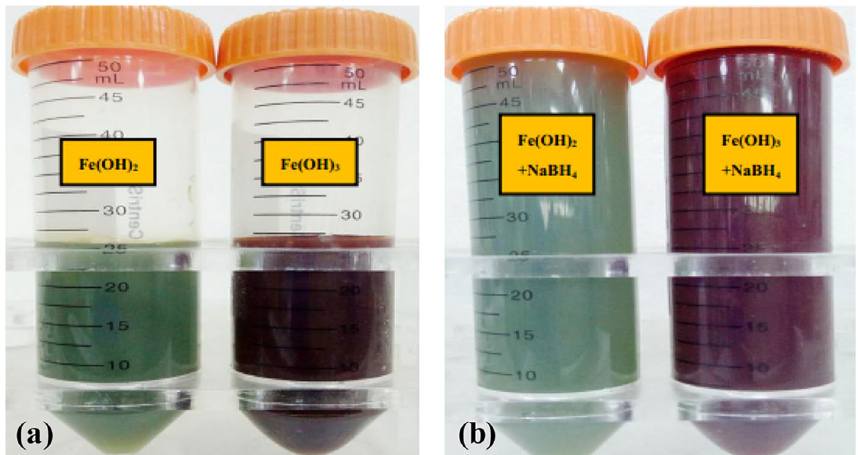
Figure 7. Pictures of suspensions of Fe(OH) 2 and Fe(OH) 3 precipitates before ( a ) and after treated with NaBH 4 solution ( b